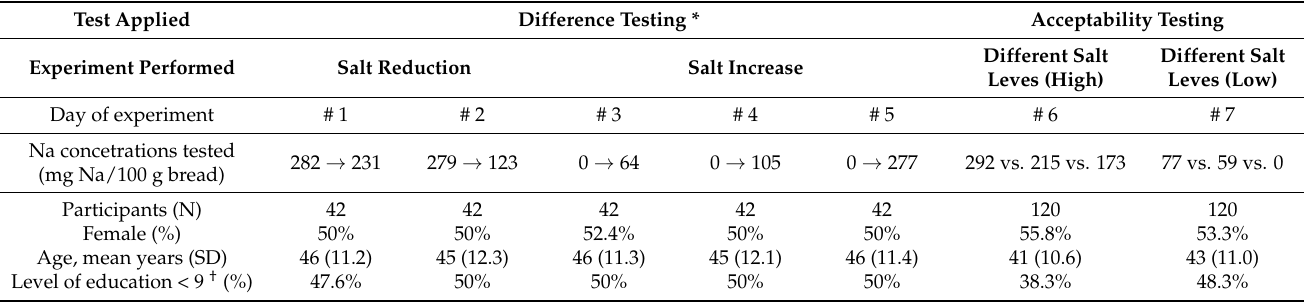
Table 1. Tests performed and sociodemographic characteristics of